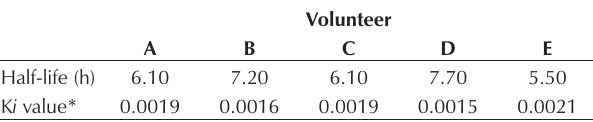
Survival of hepatitis A virus on the hands of adult volunteers